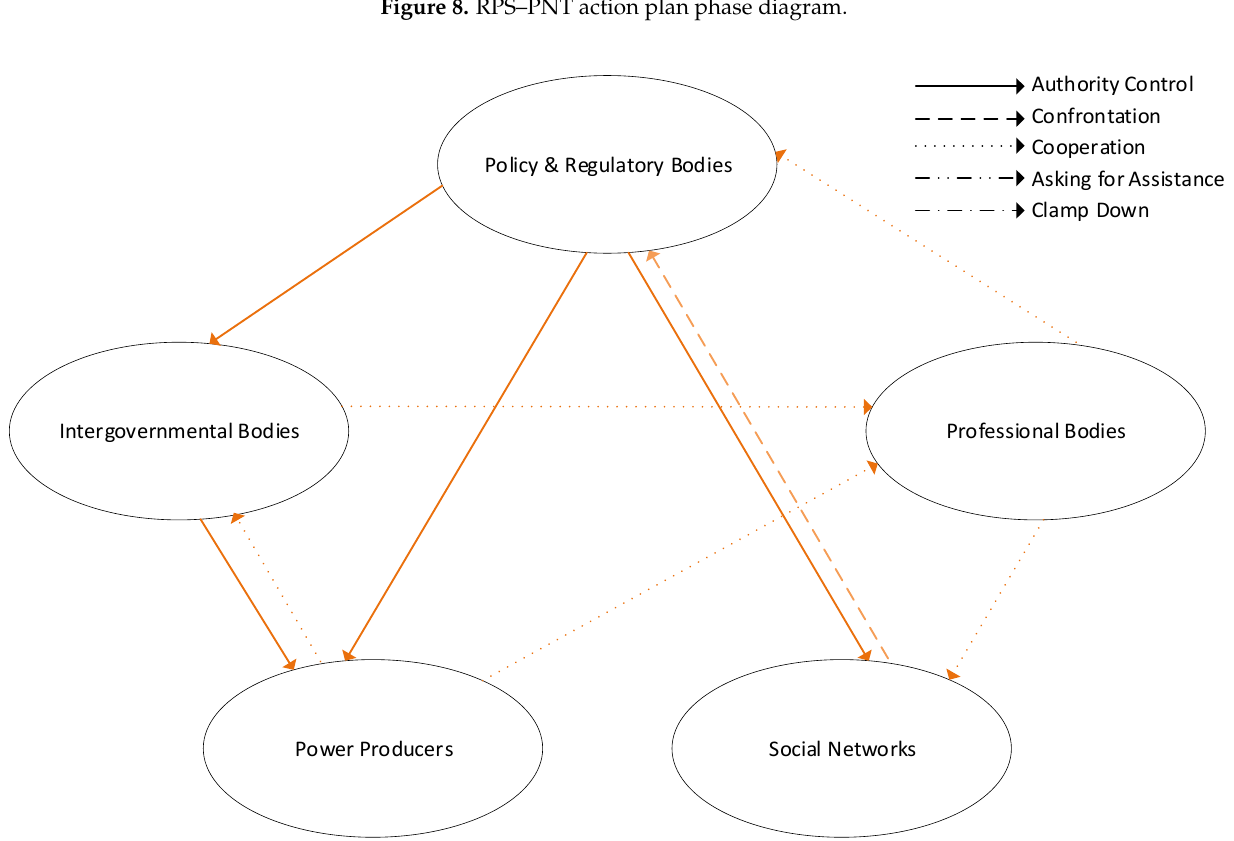
Figure 8. RPS–PNT action plan phase diagram.